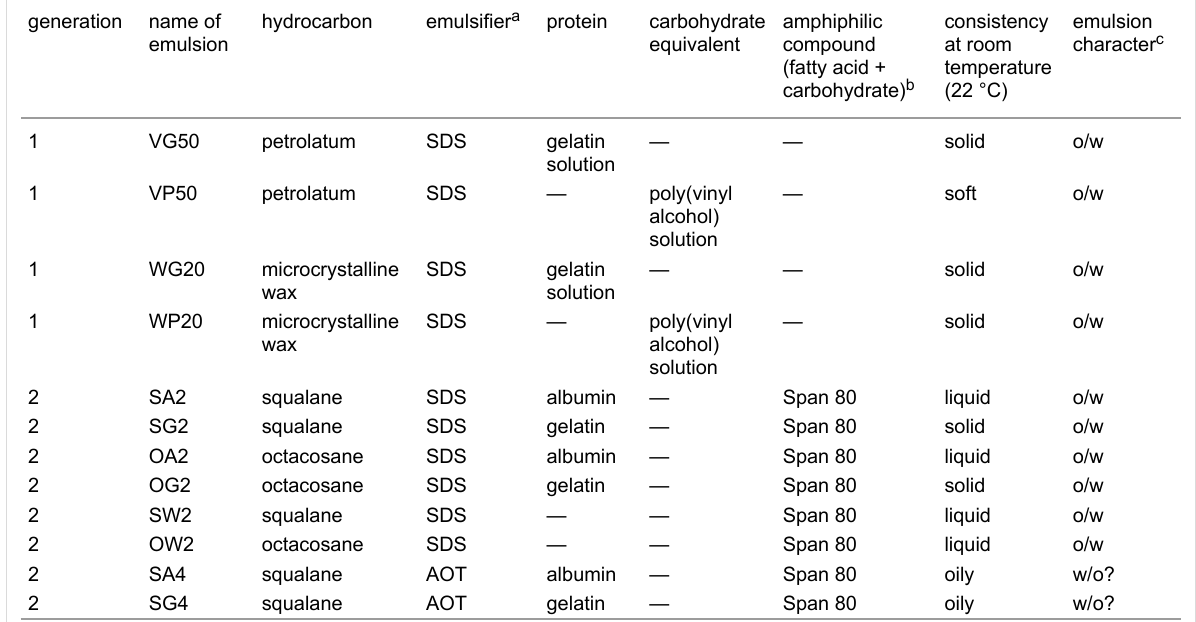
Table 1: List of the prepared synthetic emulsions and their main composition.